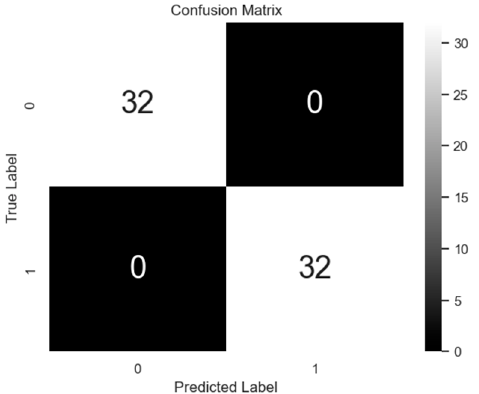
Figure 9. Confusion matrix of actual vs. predicted labels (0 = train crossing/other, 1 = minor impact).